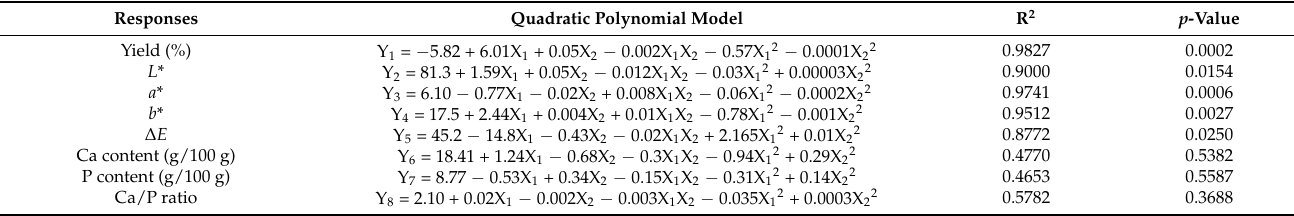
Table 2. Quadratic models of hydroxyapatite